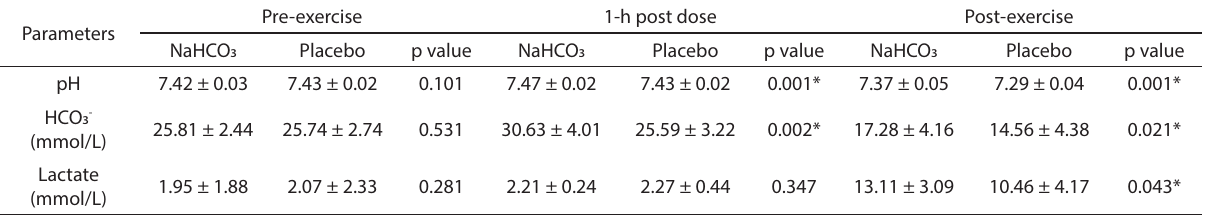
and placebo at baseline (pre-exercise), 1 h after ingestion, and at after 3